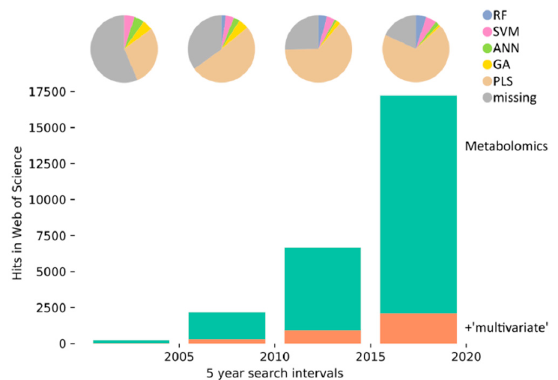
Figure 1. History of machine learning (ML) in metabolomics. The graph shows the frequency of articles mentioning ‘metabolomics’ (green bars) or ‘metabolomics’ and ‘multivariate’ (orange bars)